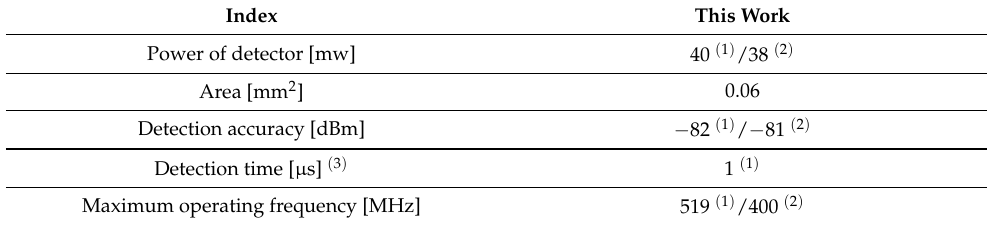
Table 2. Summary of detector parameters and